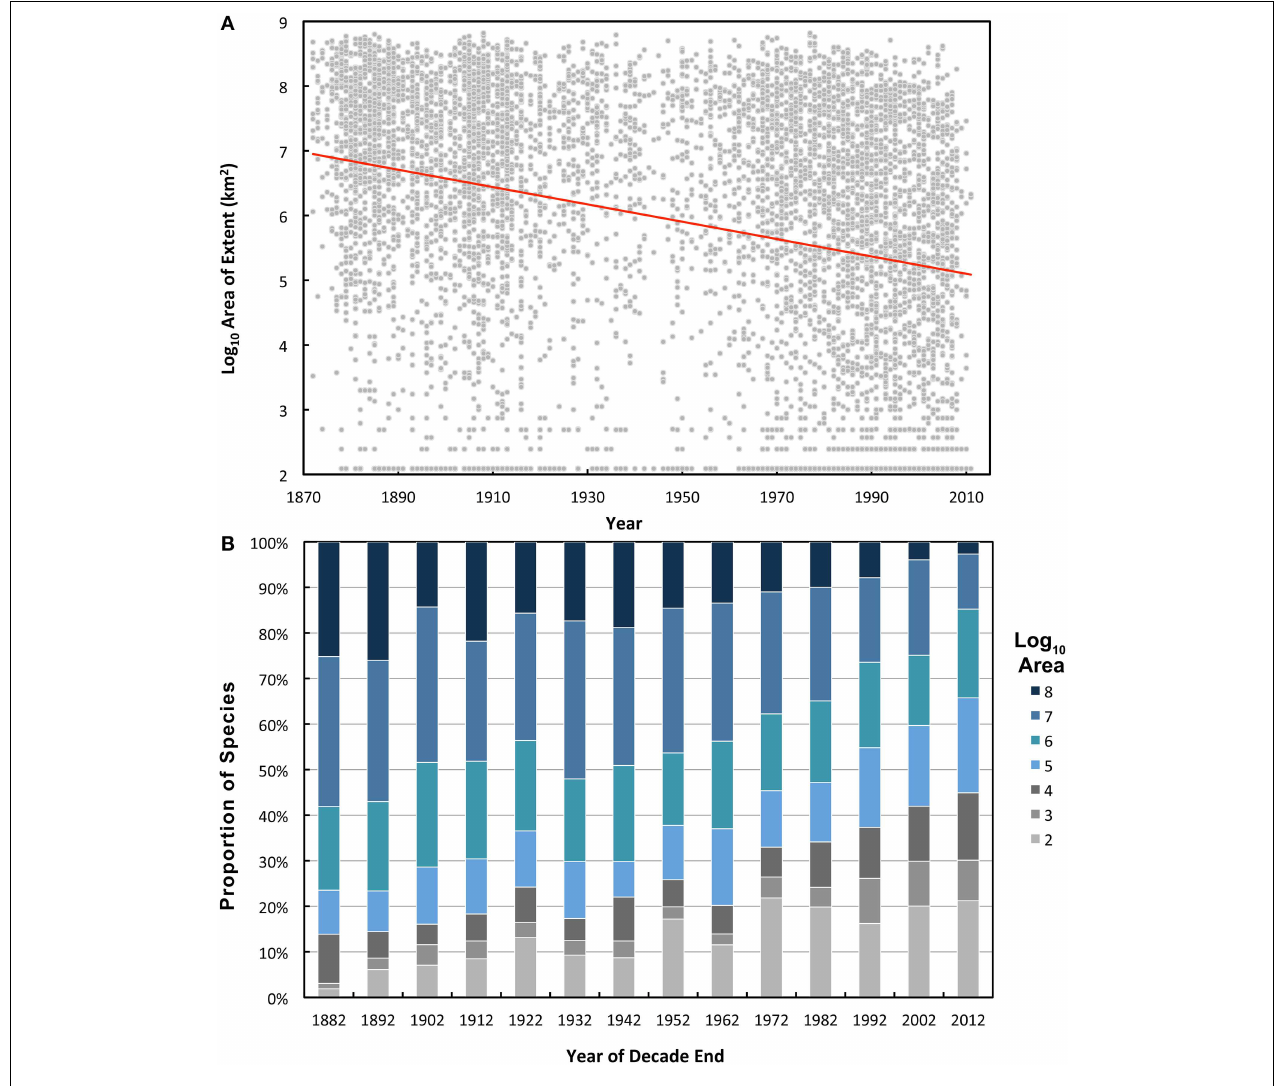
FIGURE 1 | Geographic ranges (area of extent) of deep-sea species described each year. Only species with two or more records are shown. (A) Log-transformed range size for each species in the dataset